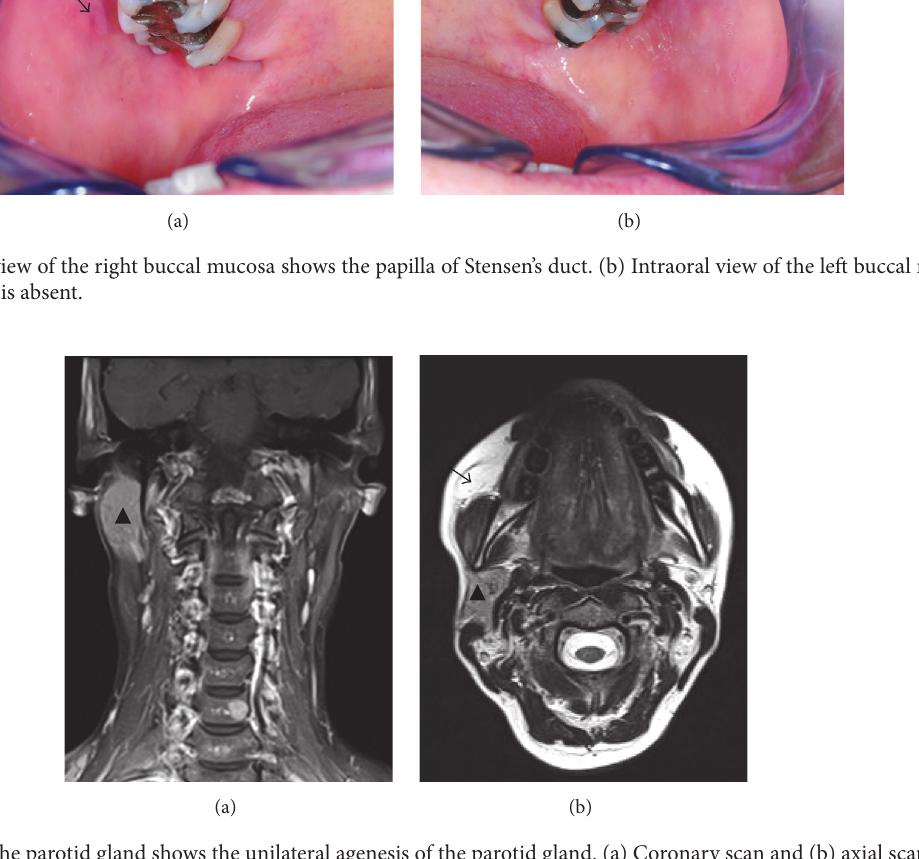
Figure 2: MRI scan of the parotid gland shows the unilateral agenesis of the parotid gland. (a) Coronary scan and (b) axial scan. The arrow points to the lipoma of the cheek and the triangle points to the right parotid